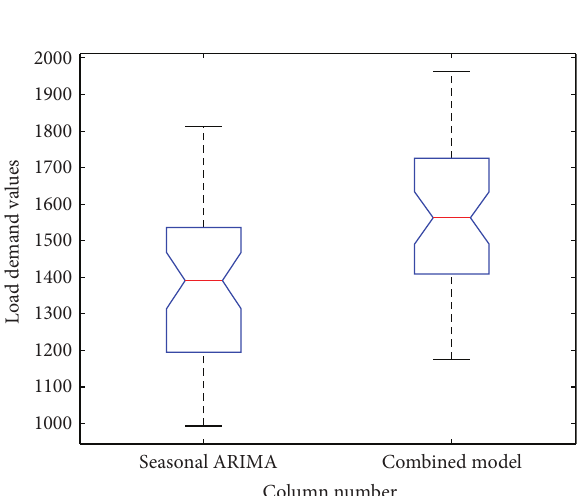
Figure 9: Actual and forecasted load demand values.